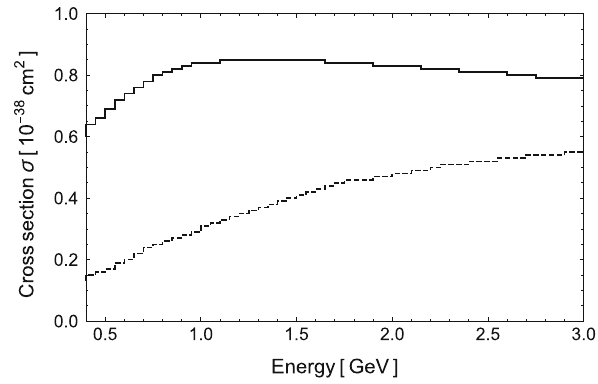
Fig. 10 The cross section for charged current quasi-elastic scatterings ν (cid:18) n → (cid:18) − p and ¯ ν (cid:18) p → (cid:18) + n ( (cid:18) = e , μ ). The solid line corresponds to the cross section for ν (cid:18) , and the dashed line to that for ¯ ν